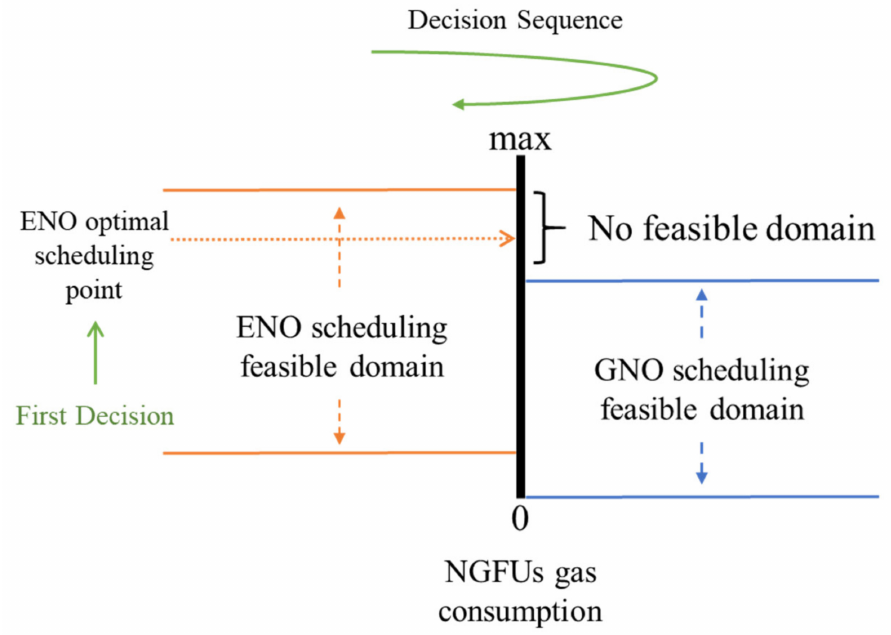
Figure 3. The diagram of traditional